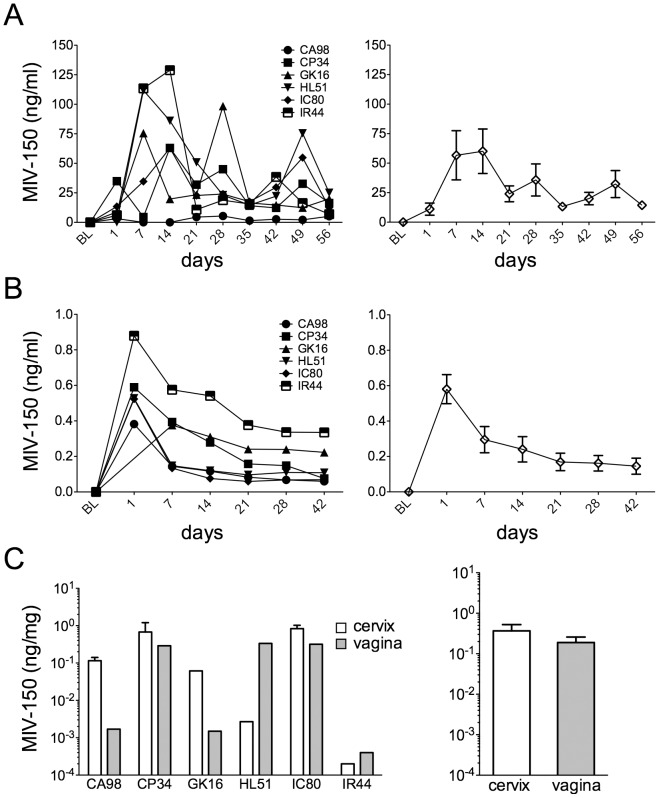
Sustained in vivo release of MIV-150 from IVRs for 56 days.Depo-Provera-treated SHIV-RT+ animals had 100 mg MIV-150 IVRs inserted for 56 d. Blood and vaginal swabs were collected prior to (BL) and after IVR insertion. Cervical and vaginal tissues were collected 1 d after IVR removal. MIV-150 levels in the vaginal swabs (A; measured by RIA) and plasma (B; measured by LCMS/MS) are shown for each animal (left panels) and the mean values for all animals (±SEM; right panels) over time. (C) MIV-150 levels in cervical and vaginal tissues (measured by LCMS/MS) are shown for each animal (left panel; 1-2 pieces of tissue measured per animal, mean±SEM shown for duplicates) and the means (±SEM, for all animals) for each tissue are shown in the right panel. Animals wearing placebo IVRs were negative for MIV-150 in swabs, plasma and tissues (not shown).